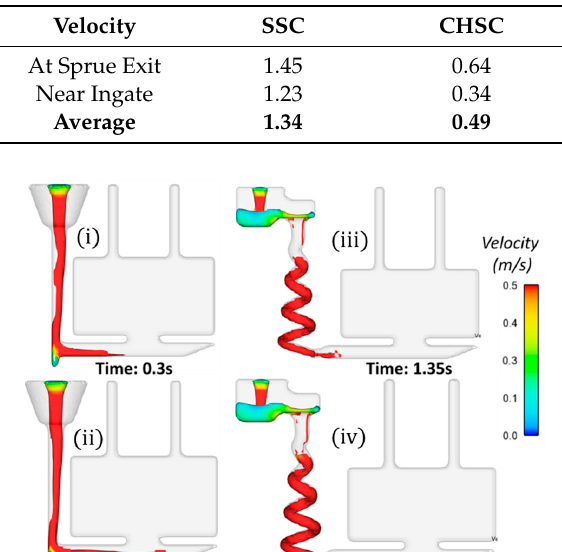
Table 2. Velocity (m / s) in SSC and CHSC from simulations.